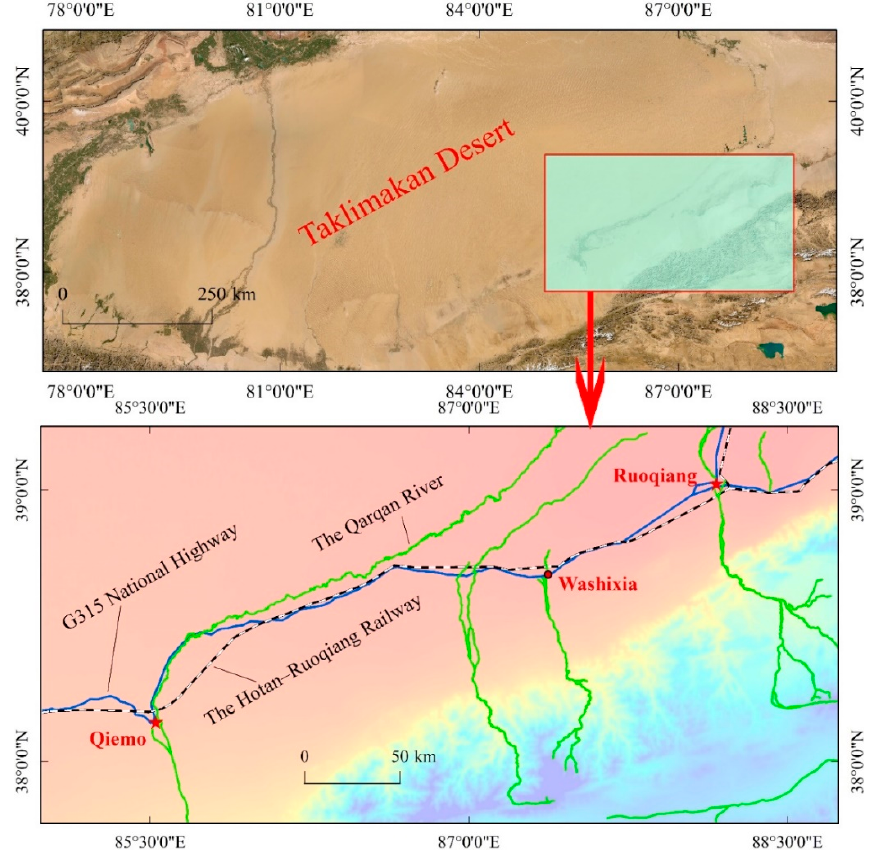
Figure 1. Overview of the study area.